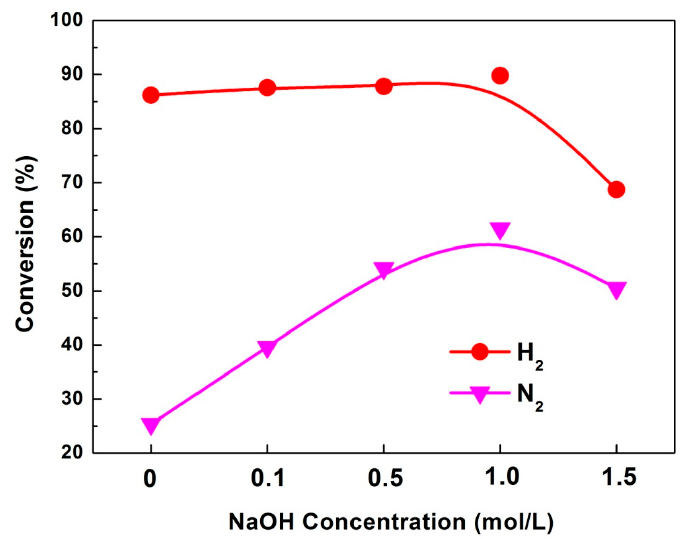
Figure 9. Influence of reaction atmosphere on methyl laurate conversion over 10 wt % Ni catalysts loaded on the hierarchical HZSM-5 treated with different concentrations of NaOH solution (0.1–1.5 M). Experimental conditions: methyl laurate (3.5 mmol), n-hexane (20 mL), catalyst (0.1 g), 280 ◦ C, 2 MPa of N 2 or H 2 (room temperature), and stirring at 600 rpm for 5 h.